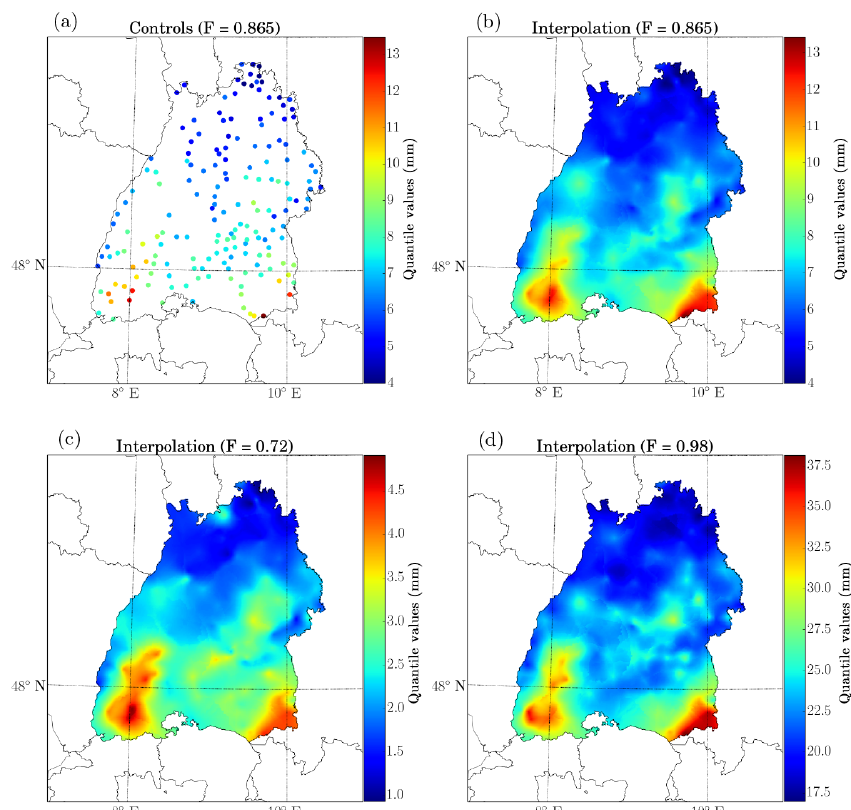
Figure 8. Illustrations for the kriging procedure of the nonparametric distributions with the daily values (1d) in the summer season using calibration sample 1 (see Fig. 7). The (a) nonparametric QV c of Q c = 0.865 at the gauges, which then lead to the interpolated values (b) using the interpolation weights φ j resulting from PK. The same interpolation weights φ j are used for the remaining quantiles, for which example results are shown for the quantiles (c) F = 0.72 and (d) F = 0.98. An exponential variogram with a range of 41km and a sill of 2.2mm 2 is